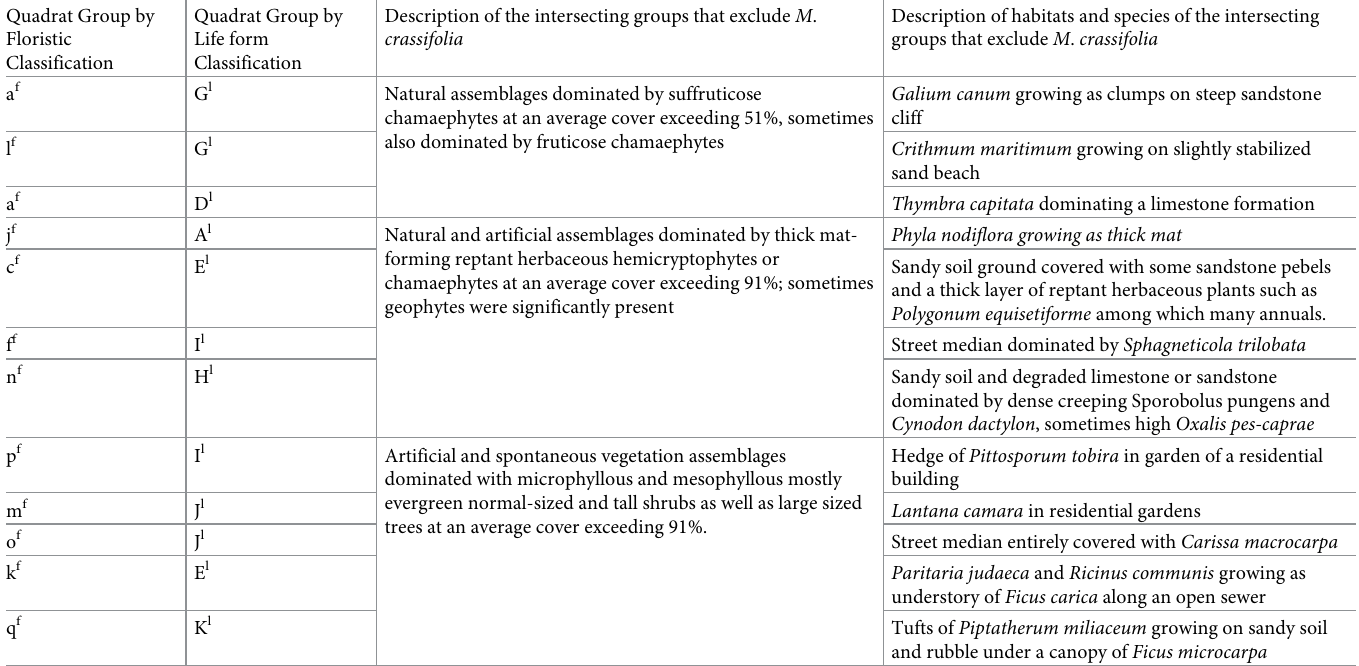
Table 4. Description of urban plant habitats (habitat condition, life forms, plant habitat, and species) unsuitable for M . crassifolia in Beirut following a stepwise approach that intersects floristic and life form data